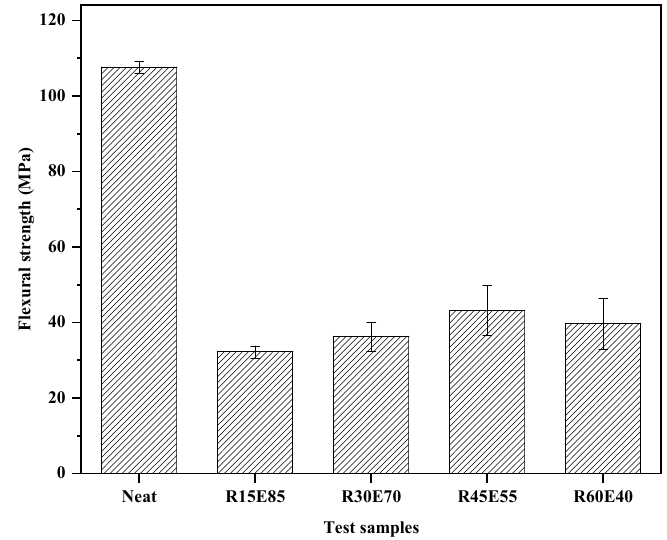
Figure 10. Flexural strength of test samples.